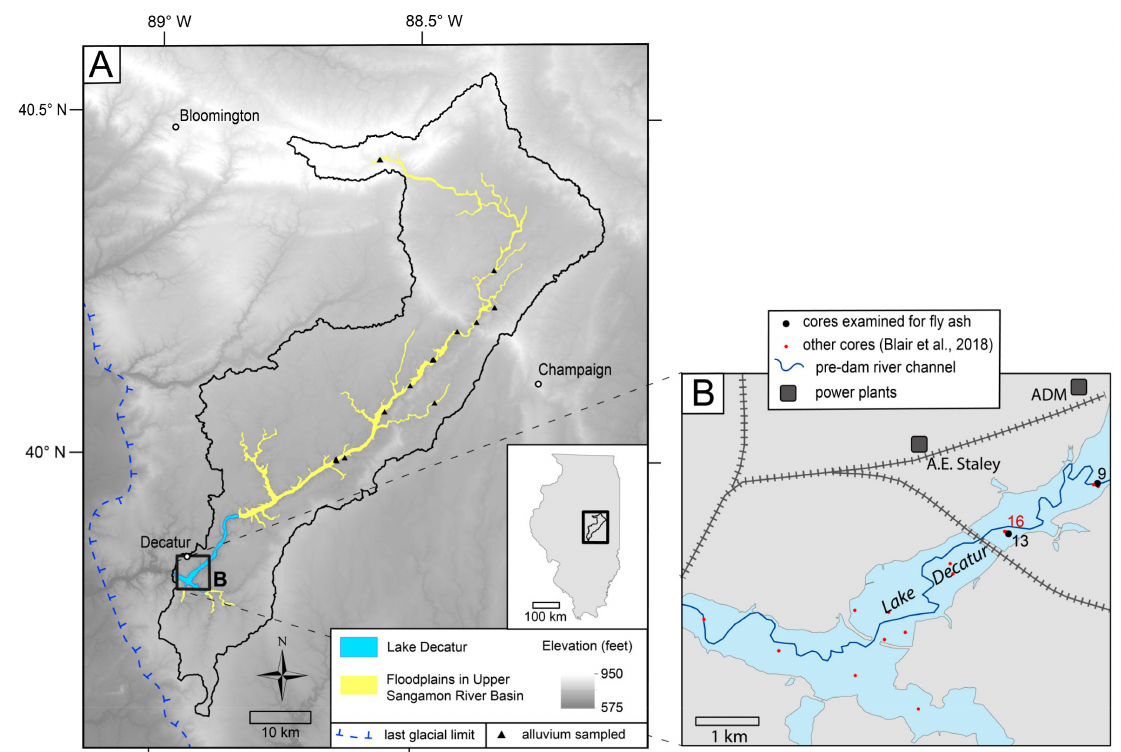
Figure 2. Location of Lake Decatur within the Upper Sangamon River Basin of central Illinois. ( A ) Sampled alluvial sites from a prior fly ash study [6]; ( B ) Shallow cores of Lake Decatur sediments [61]. Two coal burning power plants in Decatur (Archer Daniels Midland and A.E. Staley) are indicated, as well as railroad